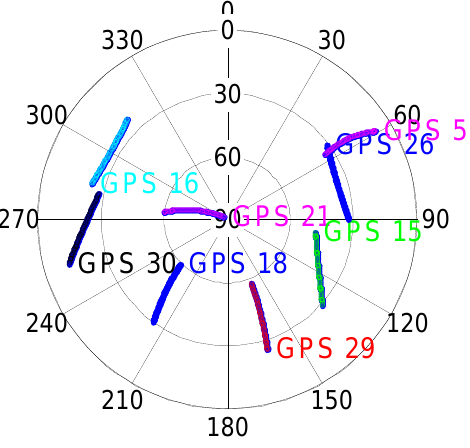
Figure 7. Sky plots of all available GPS